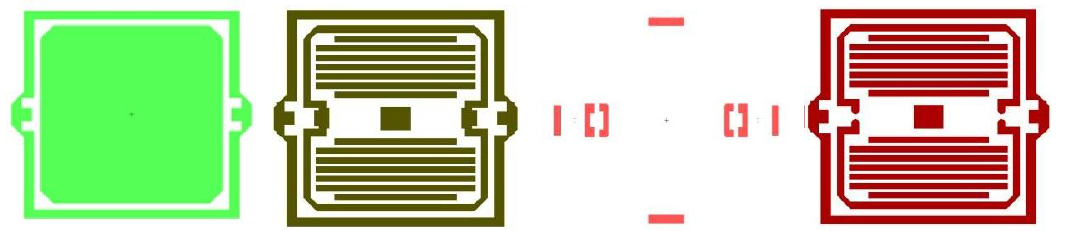
Figure11. The masks of four steps.